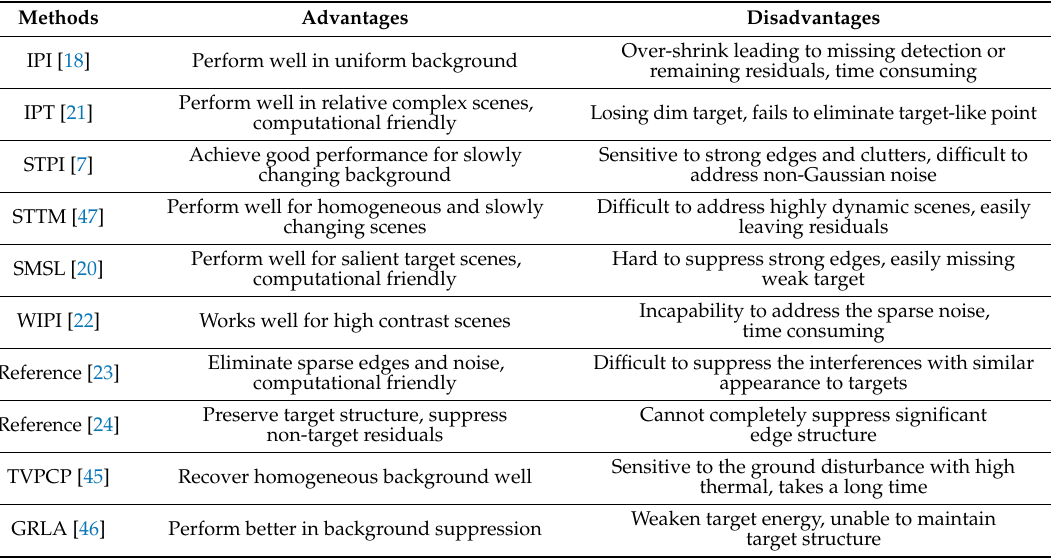
Table 1. Detailed characteristics of several related subspace learning based methods.